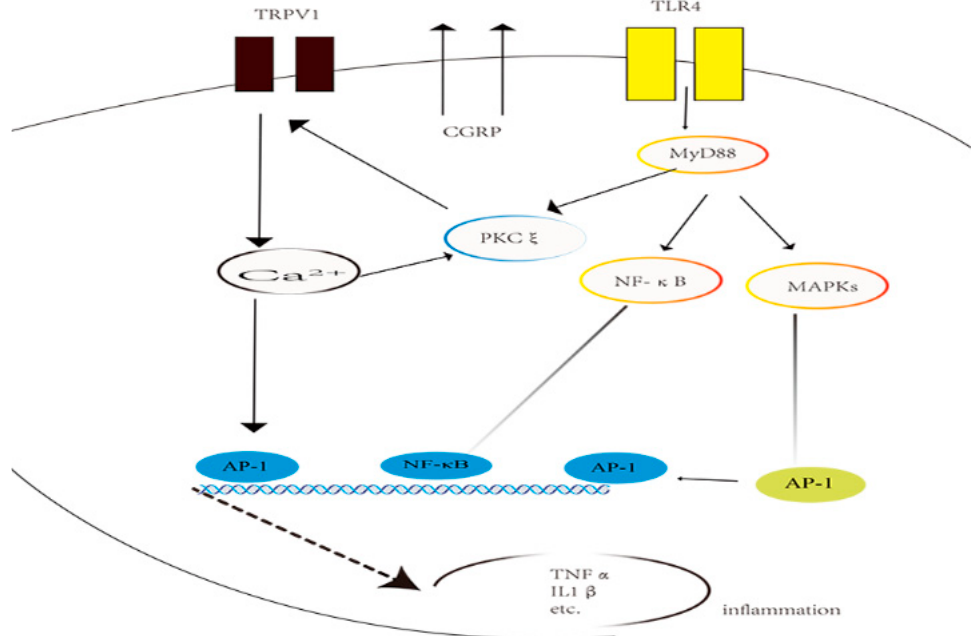
Figure 4. Activation of TLR4 and TRPV1. Key: TRPV1: transient receptor potential cation channel subfamily V member 1; TLR4: Toll-like receptor 4; CGRP: calcitonin gene-related peptide; MyD88: myeloid differentiation primary response 88; MAPKs: mitogen-activated protein kinase; NF- κ B: nuclear factor- κ B; IL1 β : interleukin-1 β ; TNF- α : tumor necrosis factor alpha; PKC- ξ : protein kinase C ξ ; AP-1: activator protein 1.